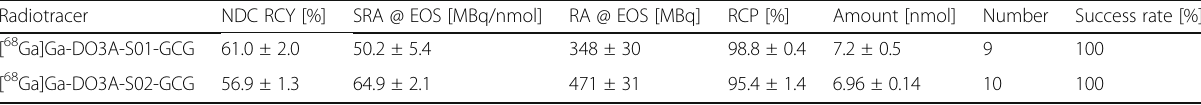
Table 2 Results of 68 Ga-labelling of DO3A-S01-GCG and DO3A-S02-GCG